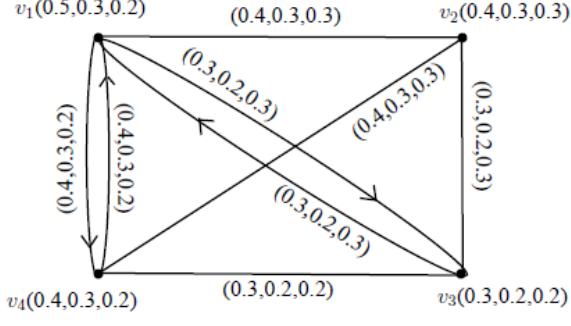
Figure 6: Strength of